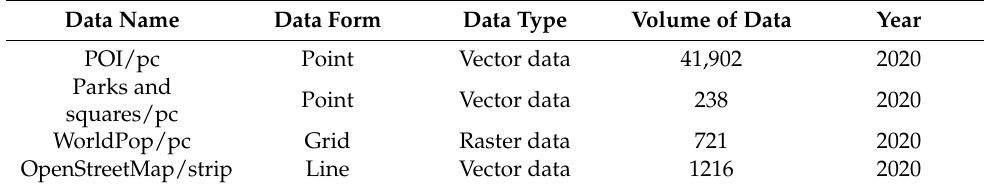
Table 2. Basic information on the study data from